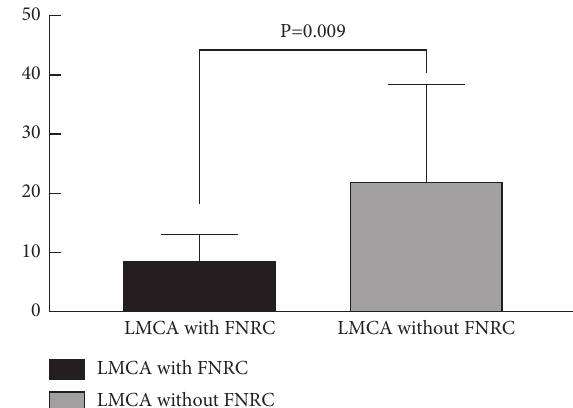
Figure 6: Comparison of the 3D deviation in the optimal projection to visualize the LMCA ostium between fluoroscopy and CTcomparing patients in whom the LMCA ostium faced the NCC-RCC commissure ( n � 32) vs. patients in whom the LMCA ostium did not face the NCC-RCC commissure ( n � 13). LMCA � left main coronary artery; FNRC � face to the NCC-RCC